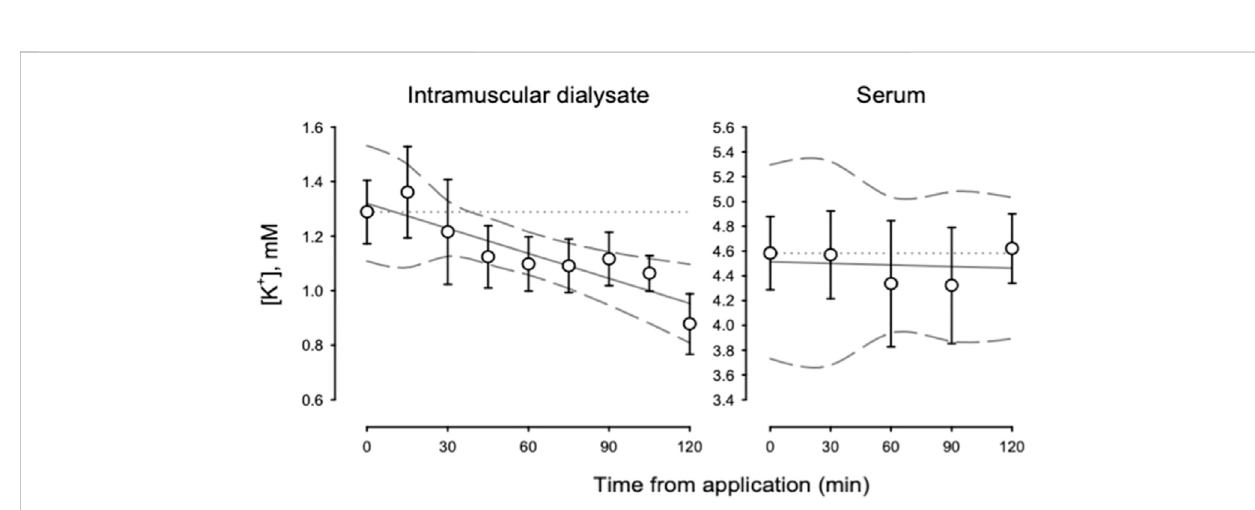
[K + ] for intramuscular dialysate (left panel) and serum (right panel) during the primary study from baseline to